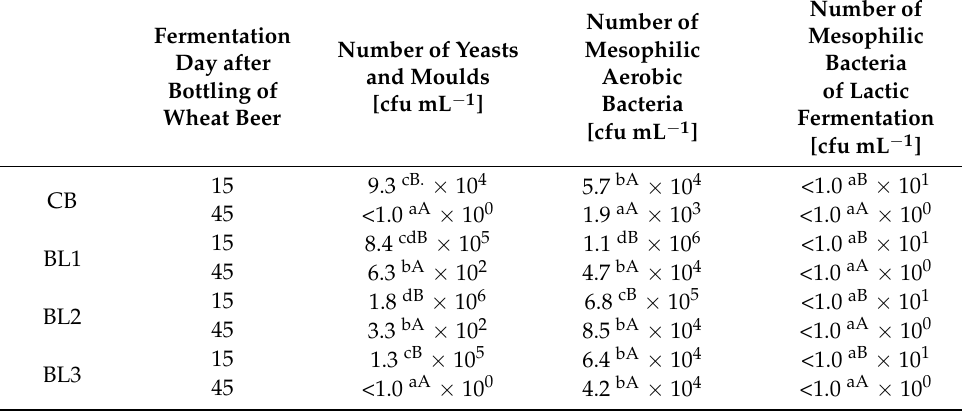
Table 3. Microbiological stability of wheat beers enriched with